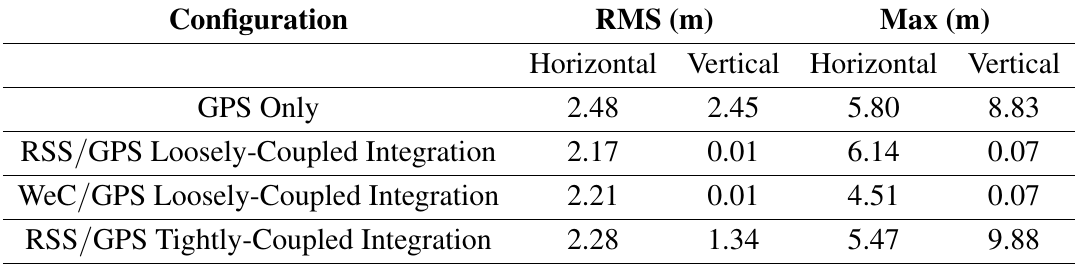
Table 3. Hybrid pseudolite/GPS statistical position error parameters: RMS and maximum errors for both horizontal and vertical